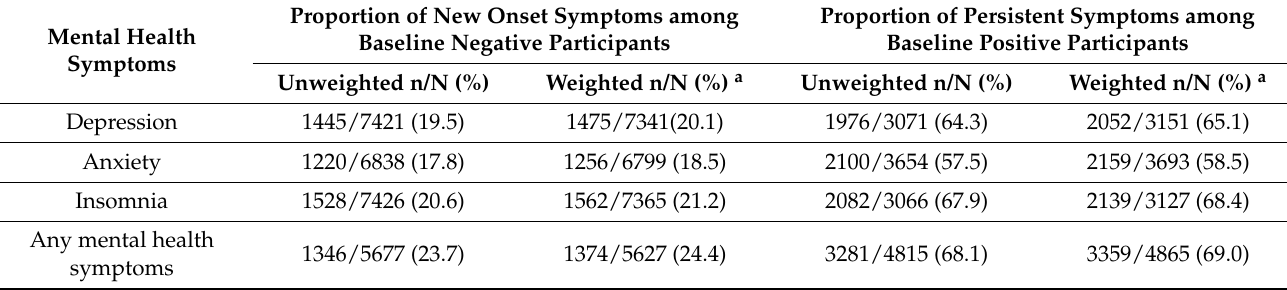
Table 3. Proportions of new onset and persistent depression, anxiety, insomnia and any mental health symptoms from baseline to follow-up survey in the